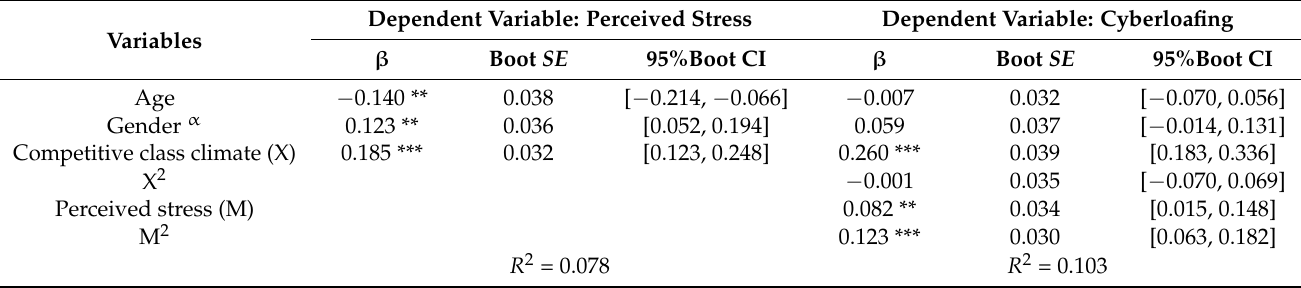
Table 2. Test of the mediation